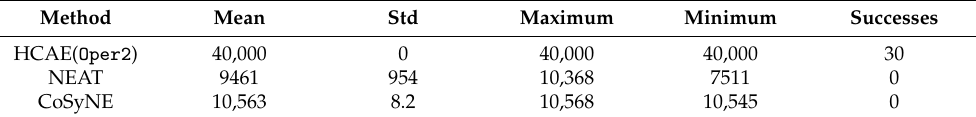
Table 7. Results of experiments on inverted-pendulum problem: average, maximum, and minimum fitness, and the number of runs ended with success, networks with 40 hidden units.